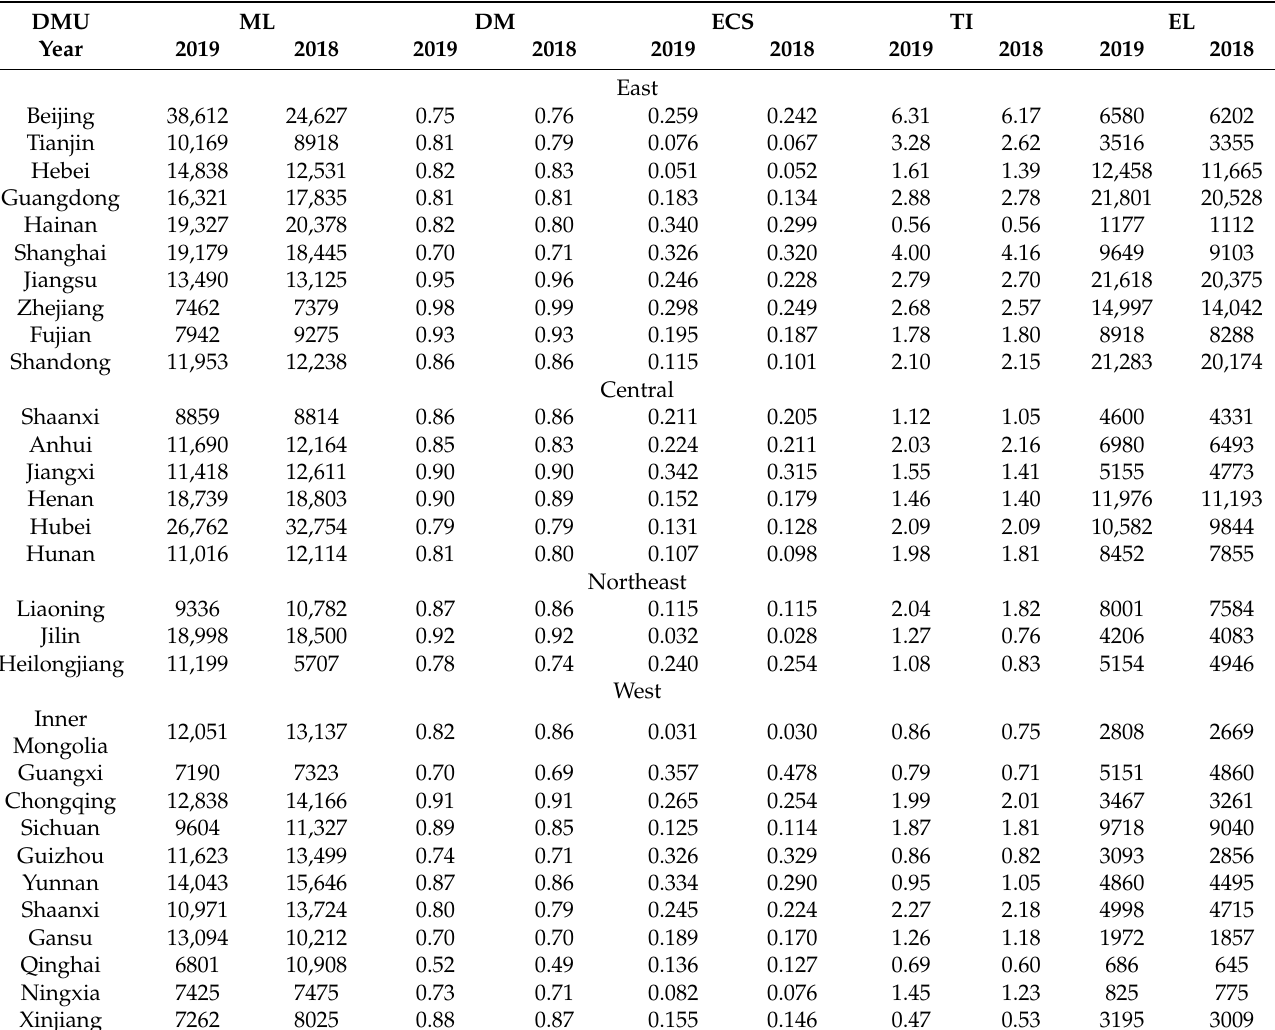
Table 3. Conditions variables by province (municipality, autonomous